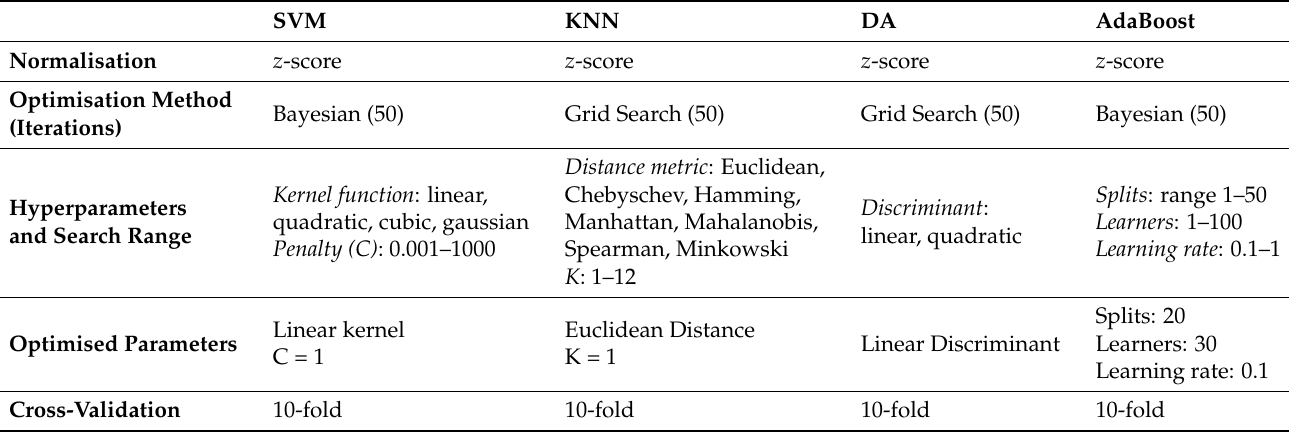
Table 6. Summary of the explored classifiers, along with the hyperparameters search range and the optimised parameters. For each classifier, the chosen normalisation and cross-validation technique are also